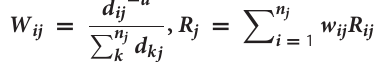
Courtemanche et al. (24) for the ionic currents of each cell.